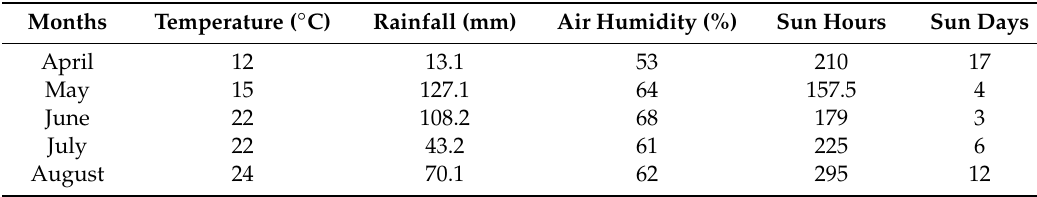
Table 1. Climatic parameters in the vegetation season of